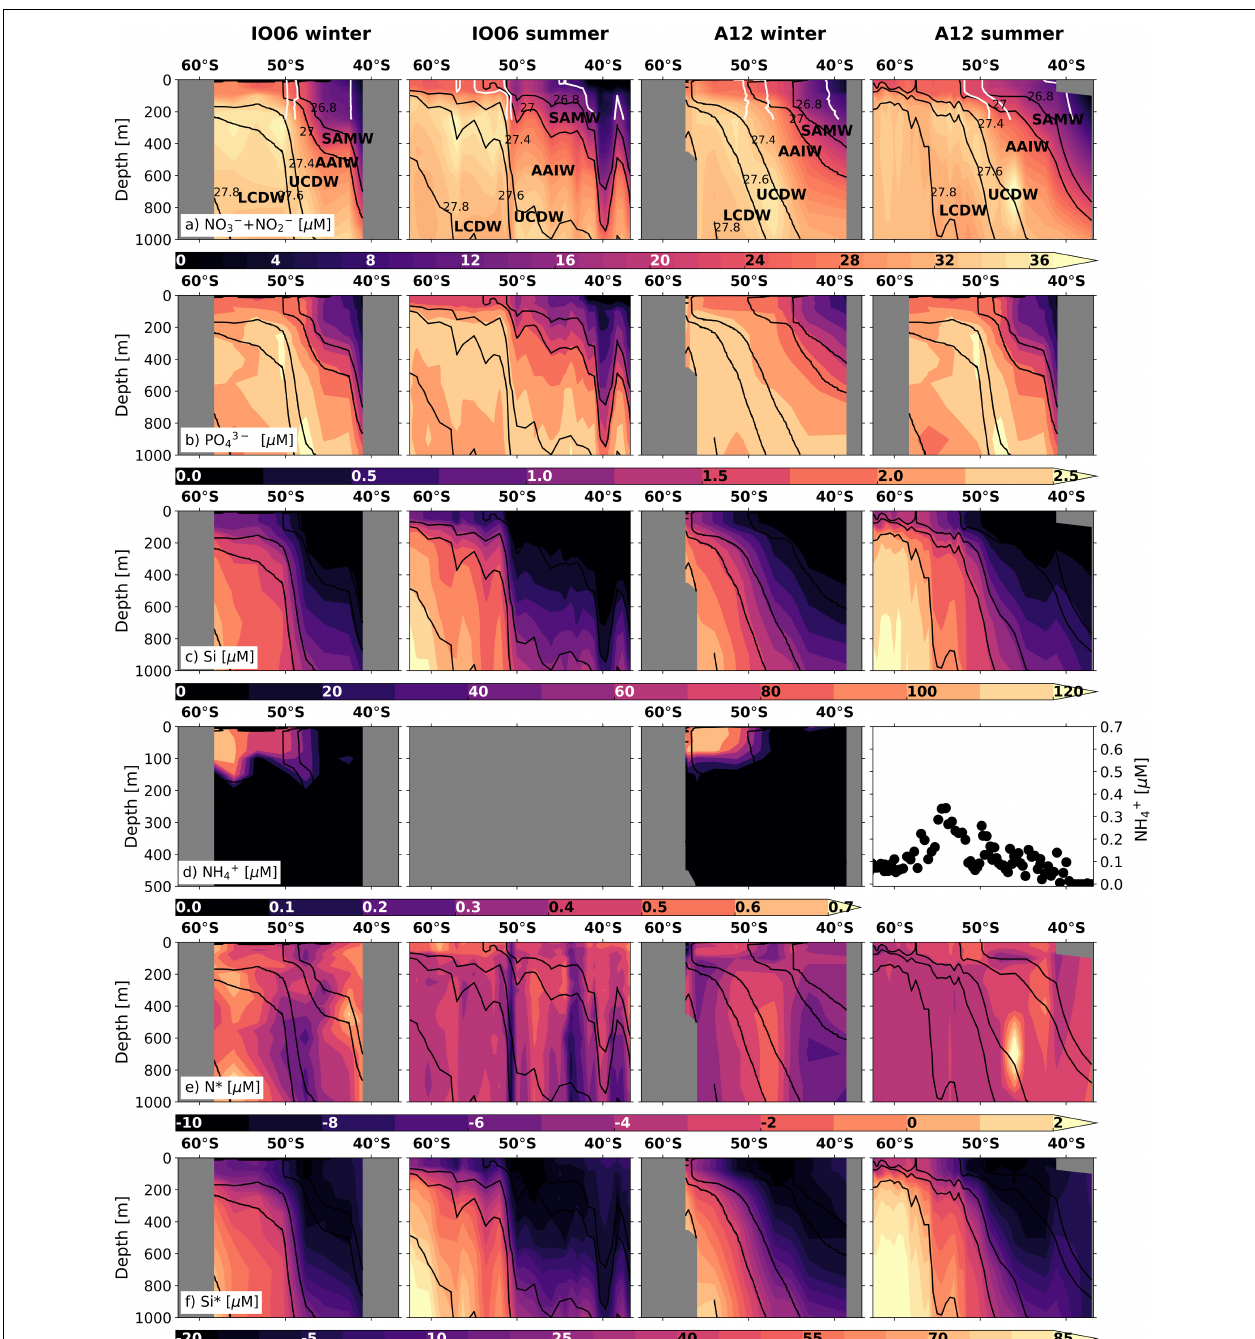
FIGURE 2 | Nutrient concentration and stoichiometry data across the Indian (WOCE IO6 line; left-hand columns) and Atlantic (WOCE A12 line; right-hand columns) sectors of the Southern Ocean in summer and winter (see Figure 1 and Supplementary Figure S1 for transect locations). Shown are the concentrations (0–1000 m, except for ammonium) of (a) nitrate + nitrite, (b) phosphate, (c) silicic acid, (d) ammonium (0–500 m), (e) N* (=[NO 3 − + NO 2 − ] – 16 × [PO 43 − ]), and (f) Si* (=[Si(OH) 4 ] – [NO 3 − ]). Winter measurements, which extend to the edge of the marginal ice zone, are for samples collected in 2017 (IO6) and 2019 (A12) (see Supplementary Information 1 for details). Summer samples were collected in 1996 (IO6; WOCE 2018) and 2008 (A12; Schlitzer et al., 2018). No summer ammonium concentration data are available for IO6, whilst the summertime values shown for A12 are for samples collected at the surface along A12 in 2019. Where ammonium data are available, N* is calculated as N* DIN = [NO 3 − + NO 2 − + NH 4 + ] – 16 × [PO 43 − ]. The major water masses defined according to Whitworth and Nowlin (1987), Park et al. (1993), Orsi et al. (1995), and Belkin and Gordon (1996) are labelled on panel a: SAMW, AAIW, Upper and Lower CDW (UCDW, LCDW). The positions of the major fronts at the time of sampling (after Deacon, 1982 and Orsi et al., 1995) are shown in white to 400 m on panel (a) : (from south to north) the Polar Front, Sub-Antarctic Front and Sub-Tropical Front. The new winter data presented here are available at https://doi.org/10.5281/zenodo.3883618.